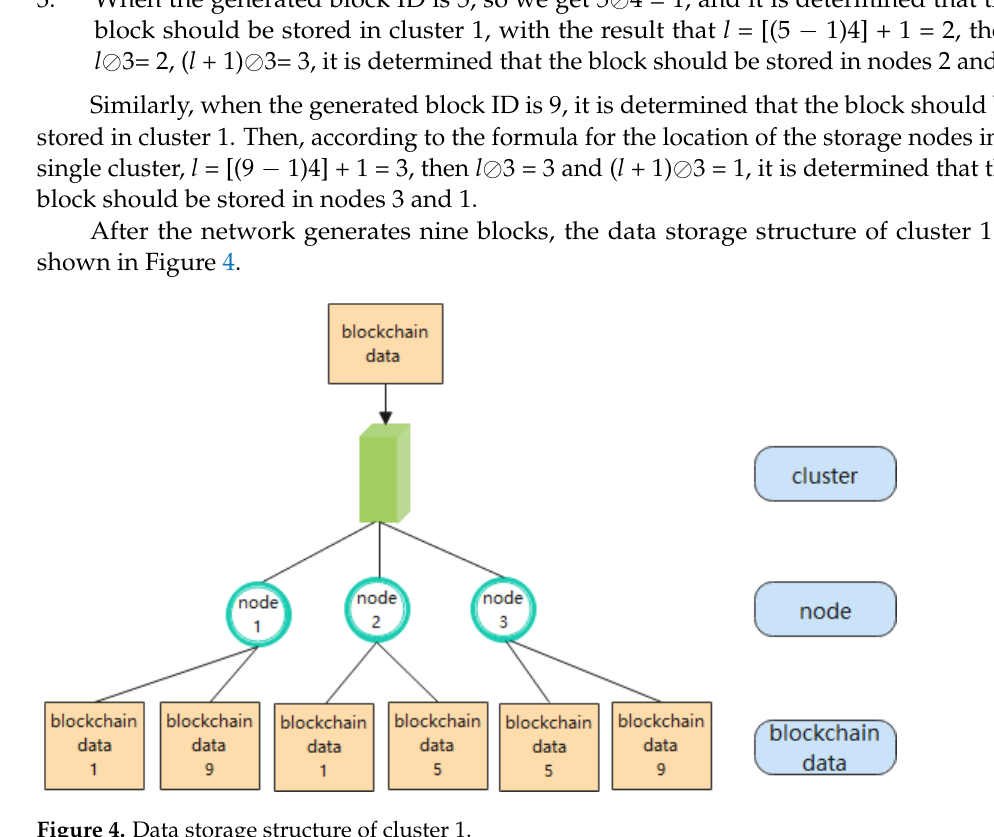
Figure 4. Data storage structure of cluster 1.